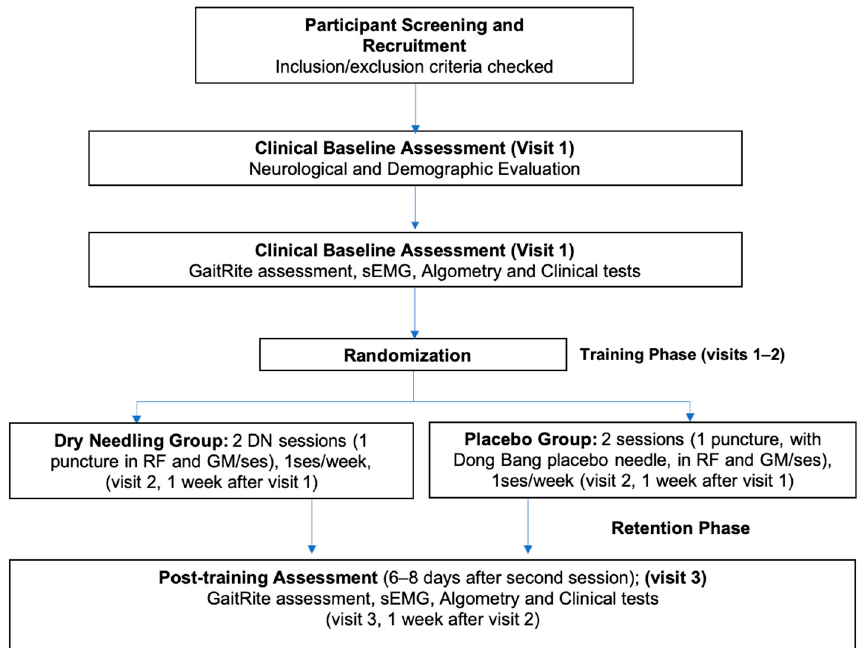
Figure 1. Study design flowchart. GM: Gastrocnemius medialis; RF: Rectus femoris; sEMG: surface Electromyography.